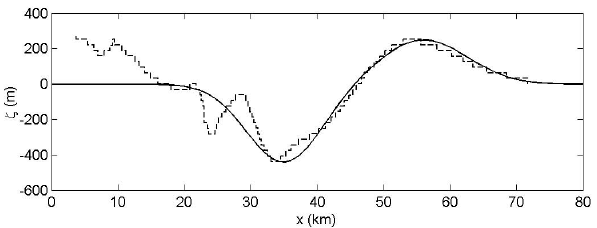
Fig. 19. Water surface profiles along 28.7 ◦ N longitude at t =25 min, simulated at resolutions of 0.5 0 (—), 1.0 0 (- -) and 2.0 0 (–.). are transferred into a new grid for further computation. In the third stage, the computational grid has a resolution of 2 0 and 0 ◦ in longitudes and 15 ◦ N–50 ◦ N in latitudes. Sponge